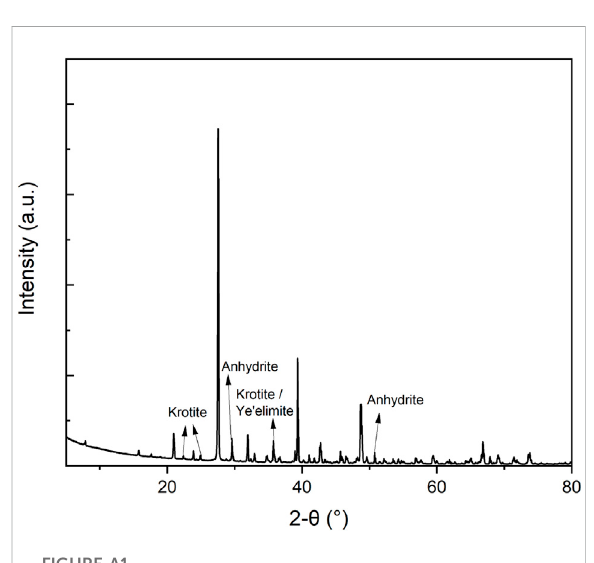
FIGURE A1 X-ray diffraction (XRD) pattern of the synthesized Ye ’ elimite used in this study. The unlabelled peaks refer to ye ’ elimite.